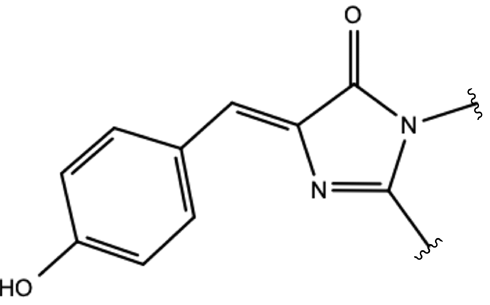
Figure 1. Schematic picture of the neutral HBDI